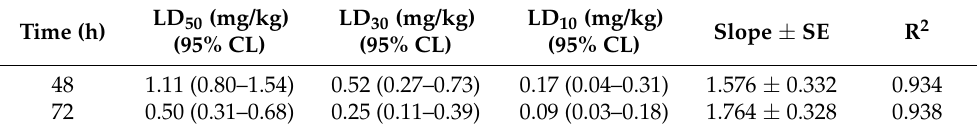
Table A1. Toxicity of fluxametamide to third-instar larvae of C .